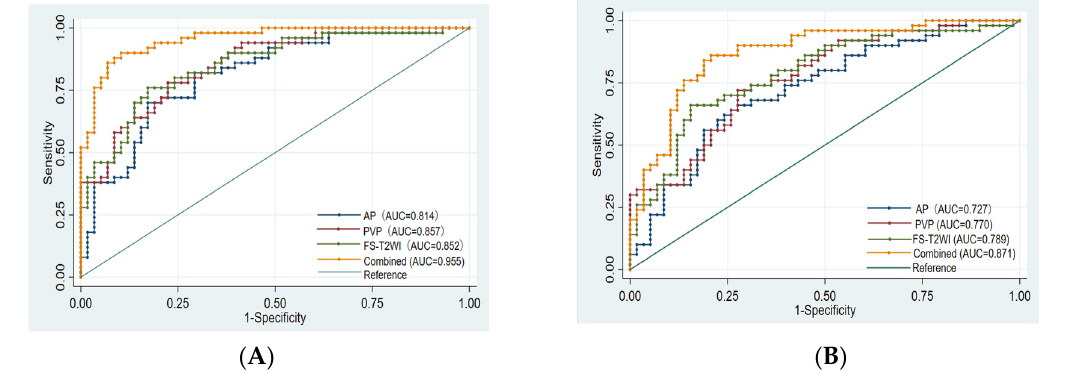
Figure 5. Comparison of the ROC curves for the prediction of PD-L2 expression by various models. ( A ): ROC of each model training set. ( B ): ROC of each model validation set. AUC: area under